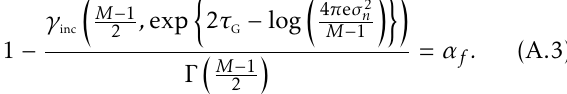
Figure 13. Near-optimal threshold τ MG simulations vs. M and for different µ